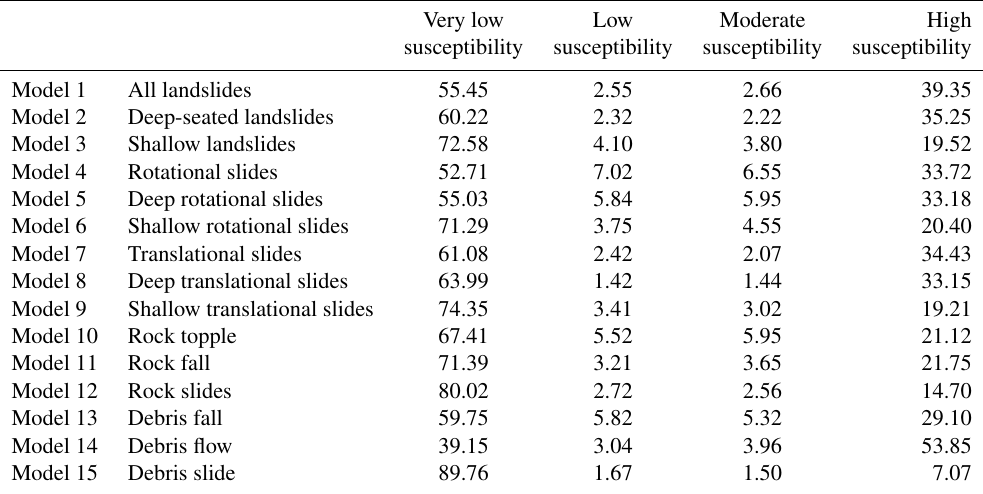
Table 5. Percentage of landslide susceptibility classes.